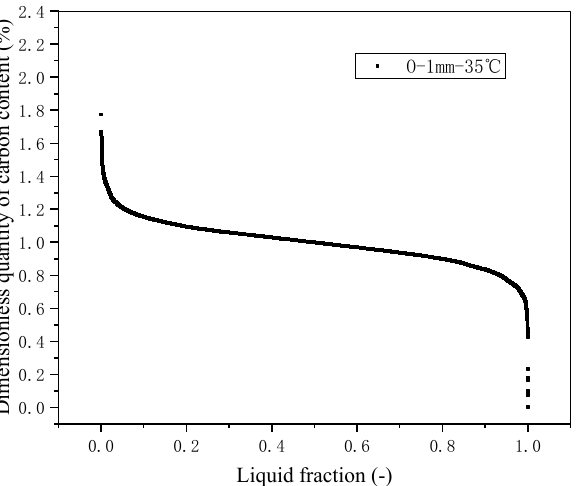
Figure 10. Variation of the dimensionless quantity of carbon content C d as a function of liquid fraction during solidification. (The results at A position in the outer curve side under 35 °C are displayed as an example.)